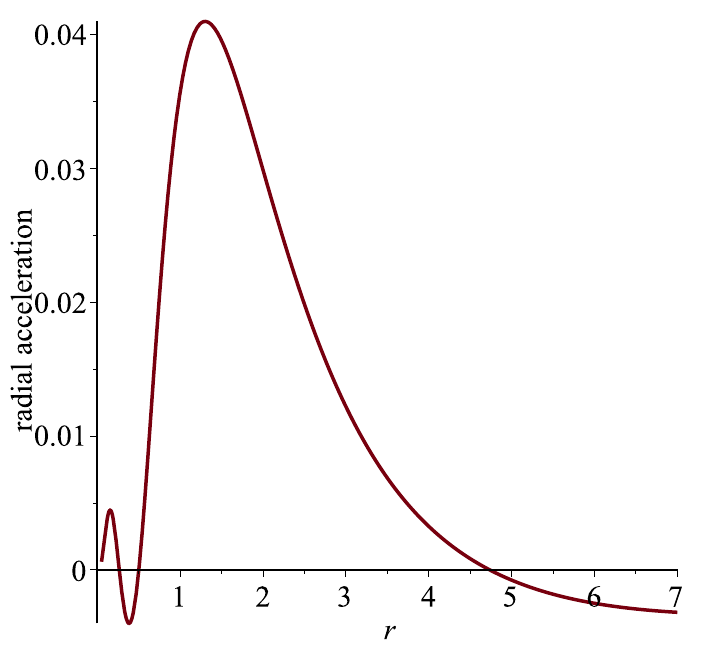
Figure 6. Behaviour of ¨ r in the Schwarzschild geometry using isotropic coordinates for m = 1 and (cid:101) = 1. Note that the curve crosses the r axis both at r = 1/2 and r = 5 + 2 third unphysical root at r = 5 − 2